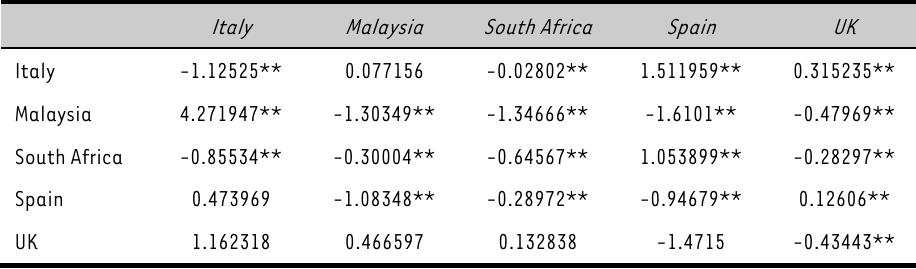
TABLE 13: Uncompensated own-price and cross-price elasticities for USA